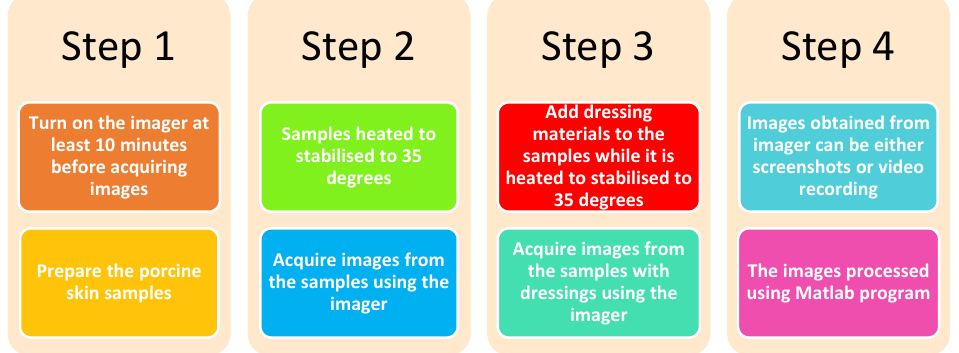
Figure 4. Methodology applied on porcine skin samples to acquire images for the skin with and without the presence of dressing materials.